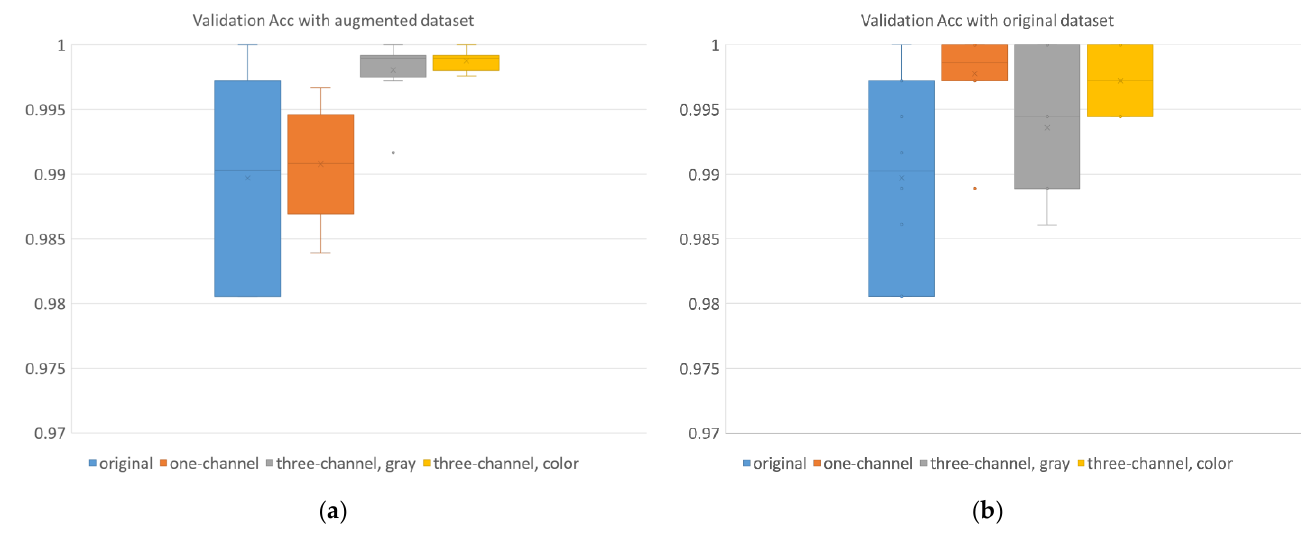
Figure 12. Boxplots of validation accuracy with MobileNetV2: ( a ) results validate with the augmented dataset; ( b ) results validate with the original dataset.